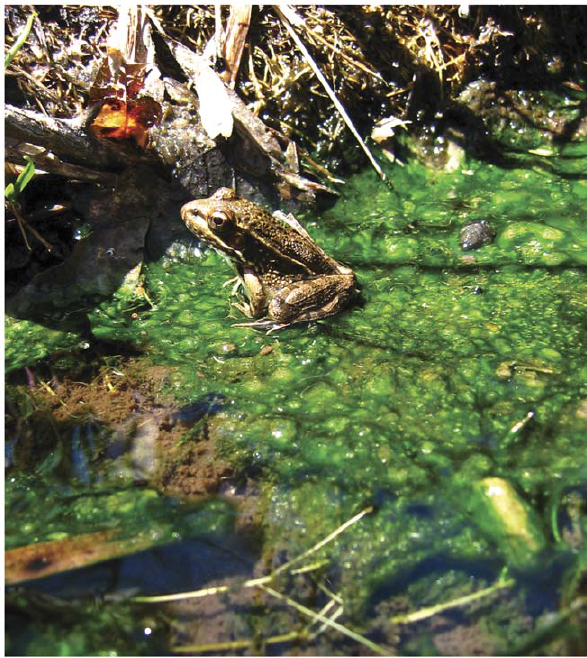
Figure 4. Lowland leopard frog in Muleshoe Hot Spring. Juvenile lowland leopard frog Rana ( Lithobates ) yavapaiensis inhabiting Muleshoe Hot Spring, a geothermal ecosystem near Willcox, Arizona. Frogs were repeatedly observed in waters 35–39 u C during this study. (Photo credit: MA Schlaepfer).